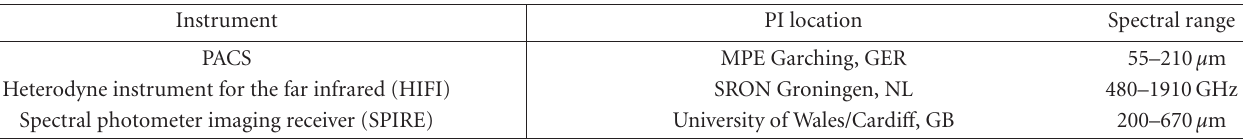
Table 1: The scientific payload of the Herschel space observatory.